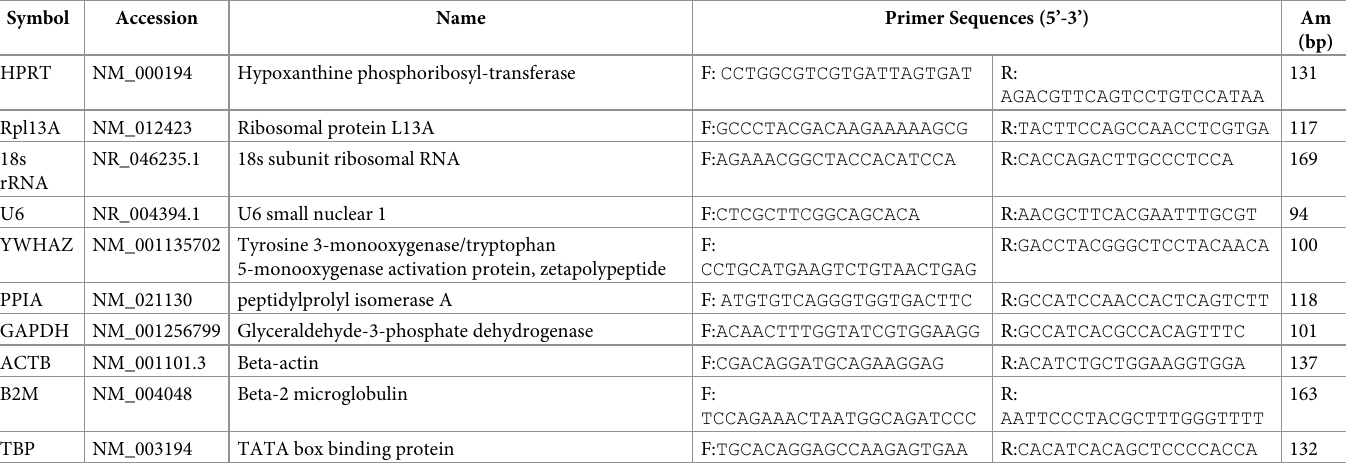
Table 1. Primers for candidate reference genes.